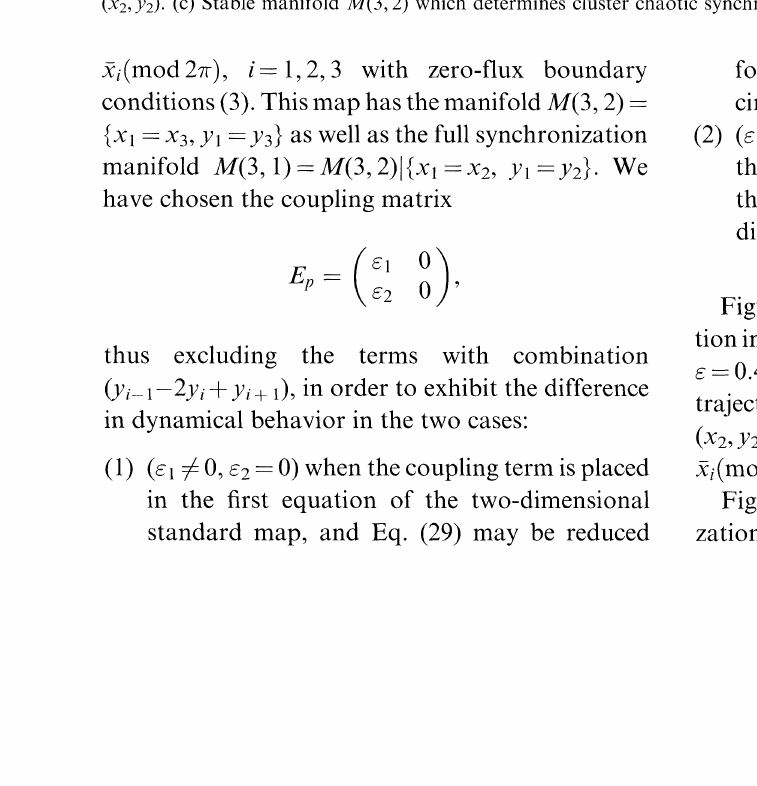
FIGURE 2 Chaotic cluster synchronization of three coupled damped standard maps. Case c--0, C20. (a) Chaotic attractor in the projection on variables of the first map (x, Yl). (b) Chaotic attractor in the projection of variables of the middle element (x2, Y2). (c) Stable manifold M(3, 2) which determines cluster chaotic synchronization. (d) Out of full